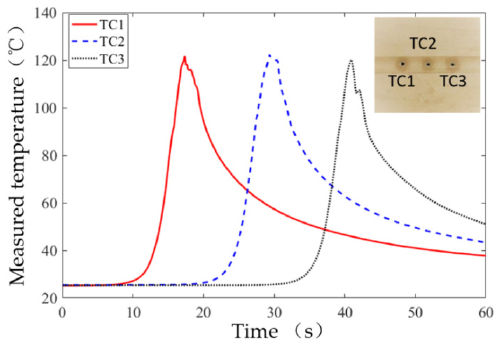
Figure 7. Temperature measurements in the bone grinding experiment using temperature sensors of three thermocouples (marked as TC1, TC2, and TC3).